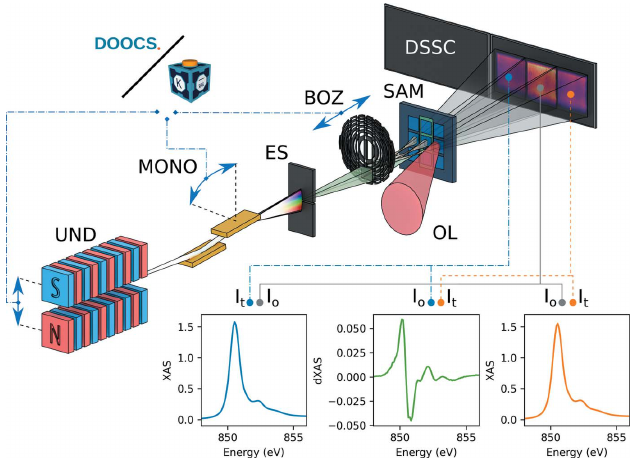
Figure 1 Scheme of the beam-splitting off-axis zone plate (BOZ) setup which is described in detail in the main